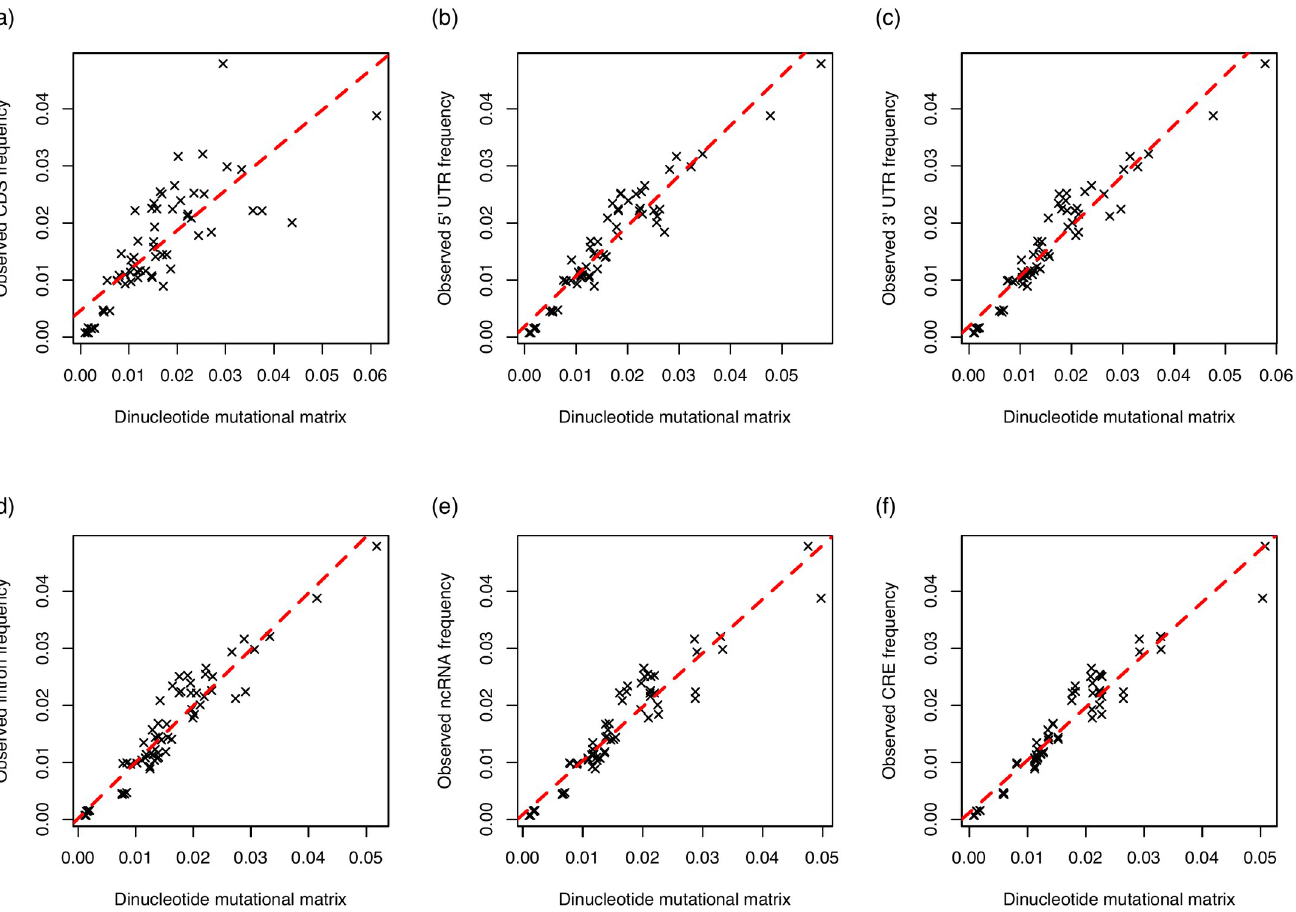
Fig 6. Observed (a) CDS, (b) 5 0 UTR, (c) 3 0 UTR, (d) intronic, (e) ncRNA, (f) CRE trinucleotide frequencies as a function of the expected frequencies of the same trinucleotides derived from a dinucleotide mutational matrix. Expected frequencies were calculated simulated DNA sequences derived from dinucleotide equilibrium frequencies. Dinucleotide frequencies were calculated from a sample of de novo mutations taking place in the bottom 20% of sequences by GC content to avoid potential GC-coupled fixation biases. Expected frequencies accurately predict what is seen in real CDS sequence (linear regression; p = 7.7 × 10 − 15 , adjusted r 2 = 0.62), 5 0 UTR sequence (linear regression; p < 2.2 × 10 –16 , adjusted r 2 = 0.90), 3 0 UTR sequence (linear regression; p < 2.2 × 10 –16 , adjusted r 2 = 0.91), intronic sequence (linear regression; p < 2.2 × 10 –16 , adjusted r 2 = 0.90), ncRNA sequence (linear regression; p < 2.2 × 10 –16 , adjusted r 2 = 0.90), and CRE sequence (linear regression; p < 2.2 × 10 –16 , adjusted r 2 = 0.93). Underlying data can be found in S6 Data.CDS, coding sequence AU : PleasedefineCDSinFigs 6 and 7 andS 2 ; S 5 ; andS 6 Figsabbreviationlistsifthisindeedisanabbreviation : ; CRE, cis -regulatory element; ncRNA, noncoding RNA.